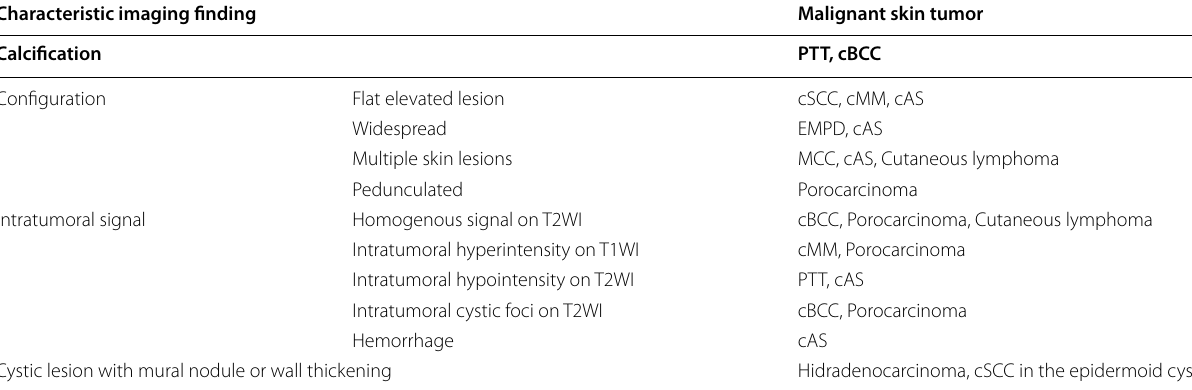
PTT proliferating trichilemmal tumor, cBCC = cAS cutaneous angiosarcoma, EMPD =